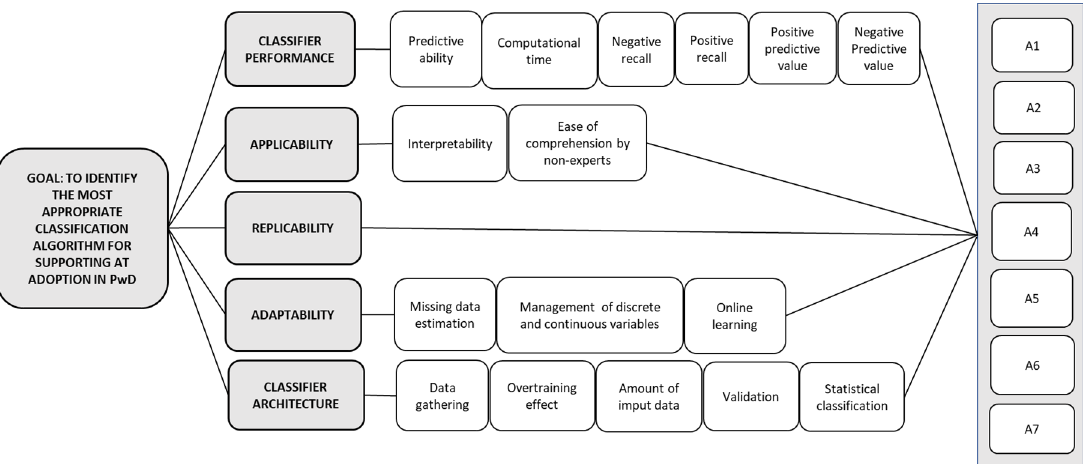
Figure 2. The proposed decision-making structure for selecting the most suitable classifier for AT adoption. Table 2. Description of classifier selection criteria.